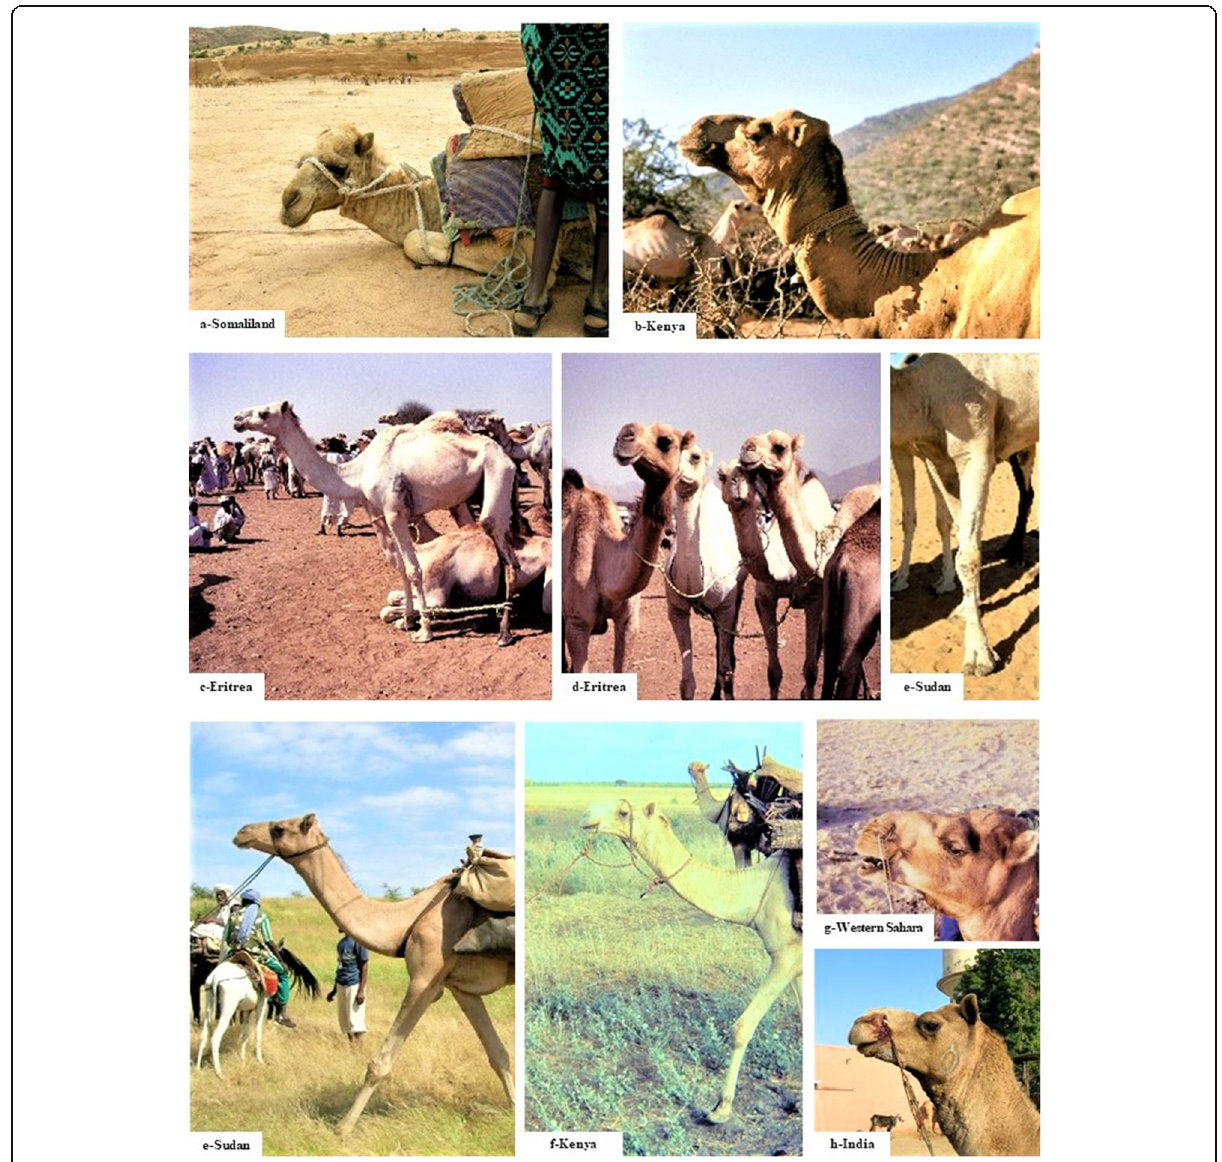
Fig. 3 Images of various camel restraints and control practices used by nomadic camel pastoralists in a variety of countries (Dioli 2012, 2013, Schwartz and Dioli 1992). a Somaliland. b , f Kenya. c , d Eritrea. e Sudan. g Western Sahara. h